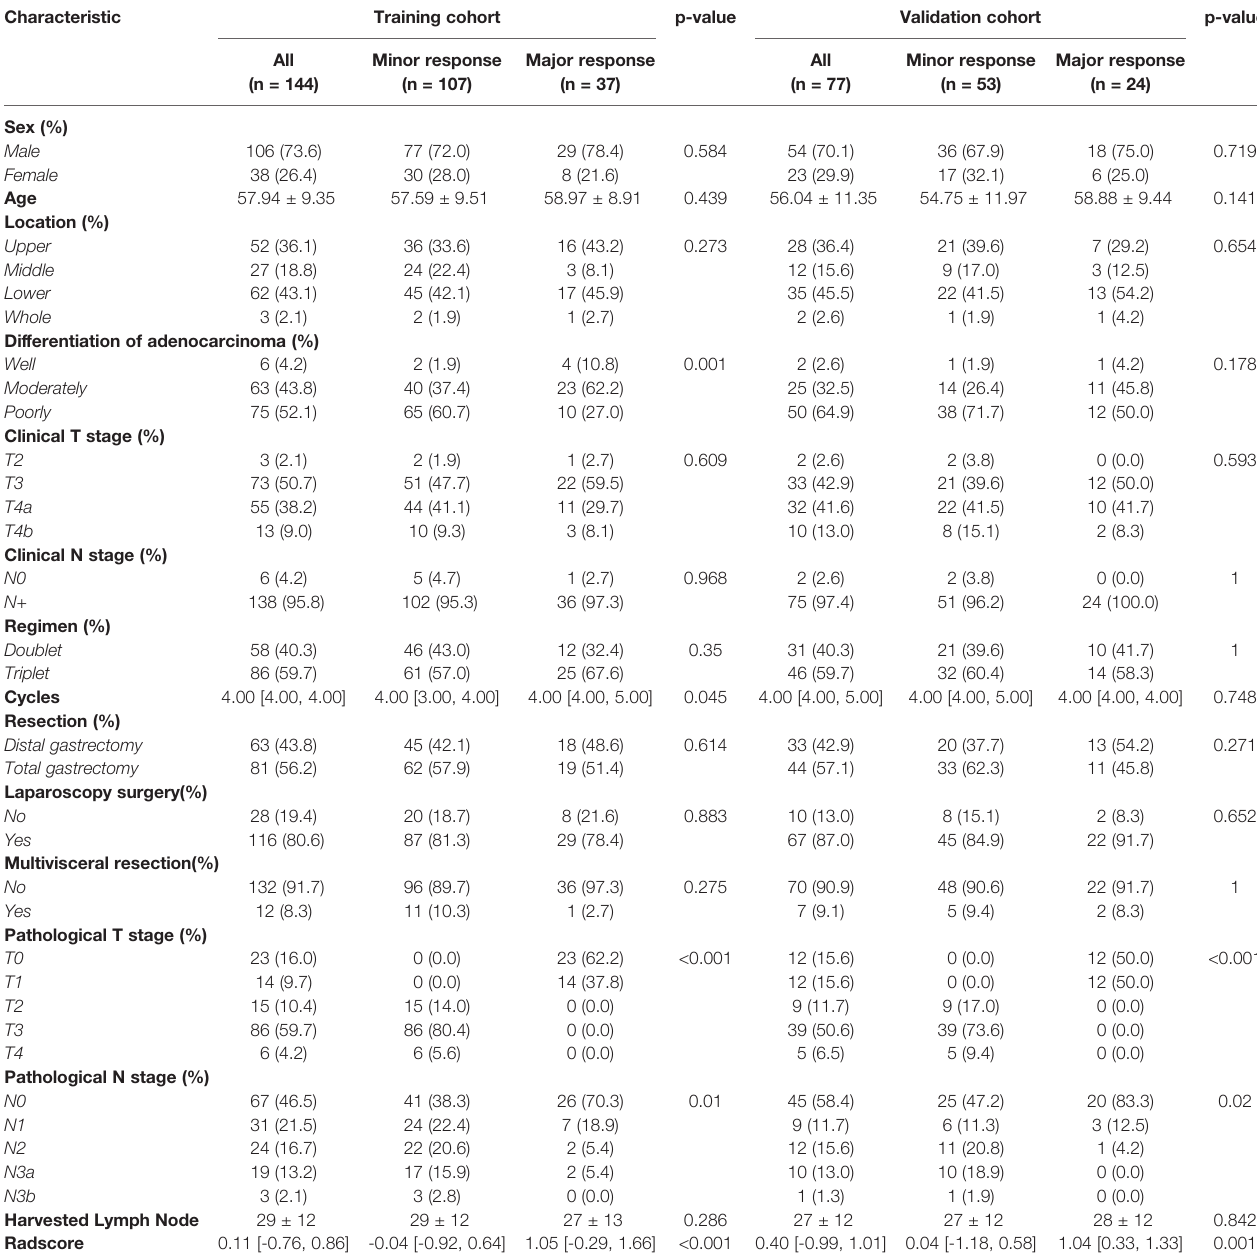
TABLE 1 | Patients characteristic in the training and validation cohort.